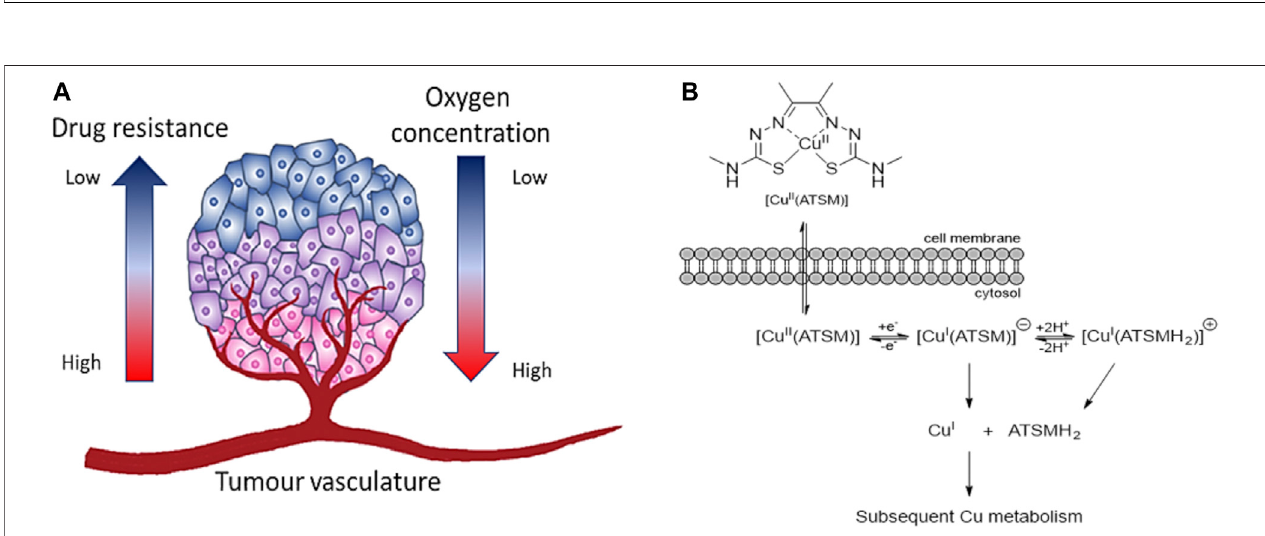
FIGURE 9 | (A) Microenvironment of hypoxic tumour. The oxygen supply becomes restricted in cells once the rate of growth of tumour cells is progressing. Cancerous cells in hypoxic conditions can develop aggressiveness, metastasis, and resistance to therapeutic agents ( fi gure adapted from Sharma et al. (2019)), (B) Schematic representation of the uptake of [Cu(ATSM)] and release of Cu(I) ions in hypoxic conditions ( fi gure adapted from Challapalli et al. (2017)).